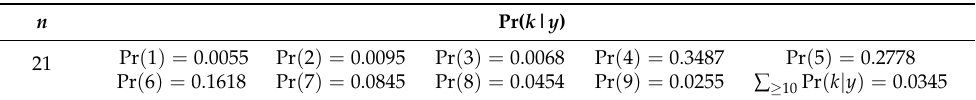
Table 8. Summary of the results of grouping for DHF data in eastern Surabaya using the EV-I mixture distribution.